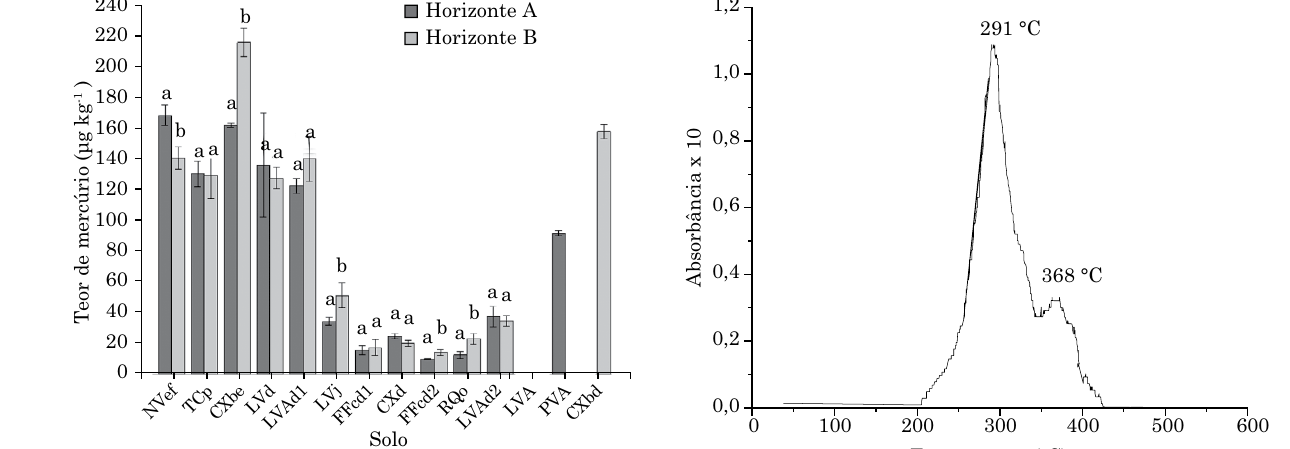
figura 2. termograma do solo cXbe (cambissolo Háplico Tb eutrófico latossólico), horizonte